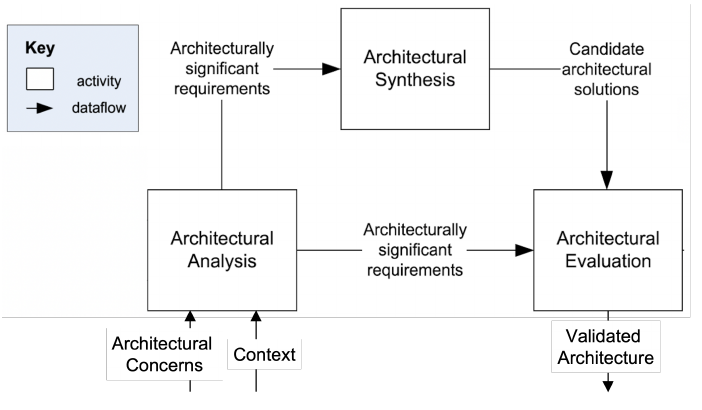
Figure 1. The architecture design activities